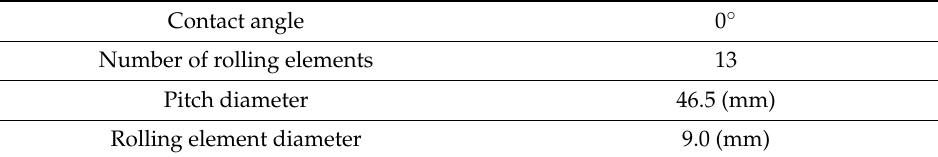
Figure 3. Data acquisition system and experimental testbed. Table 1. Bearing